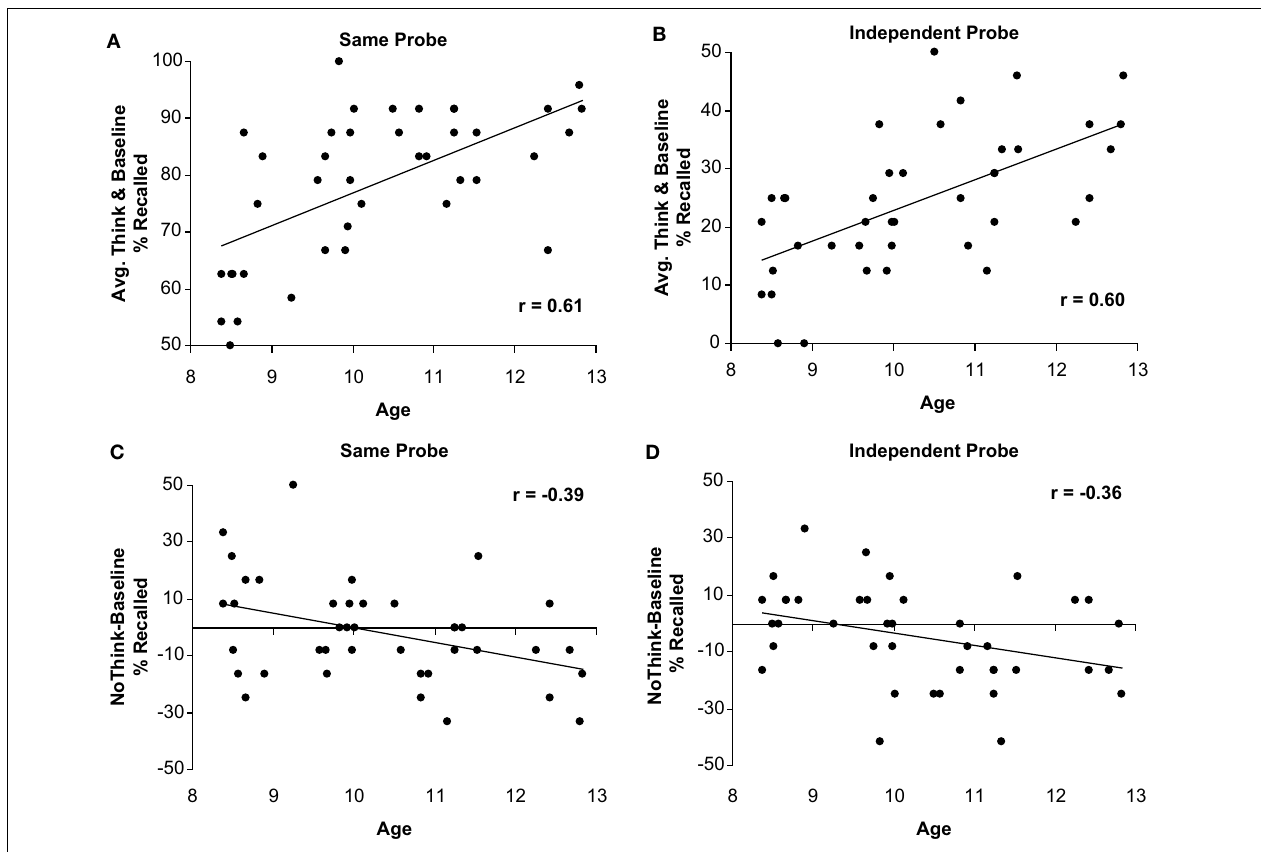
FIGURE 3 | Correlations between children’s age and performance. Negative correlation between children’s age and memory for the to-be-suppressed minus baseline items in the SP (A) and IP (B) tests; Positive association between children’s age and percent of recall for Think and Baseline conditions averaged together in the SP (C) and IP (D)